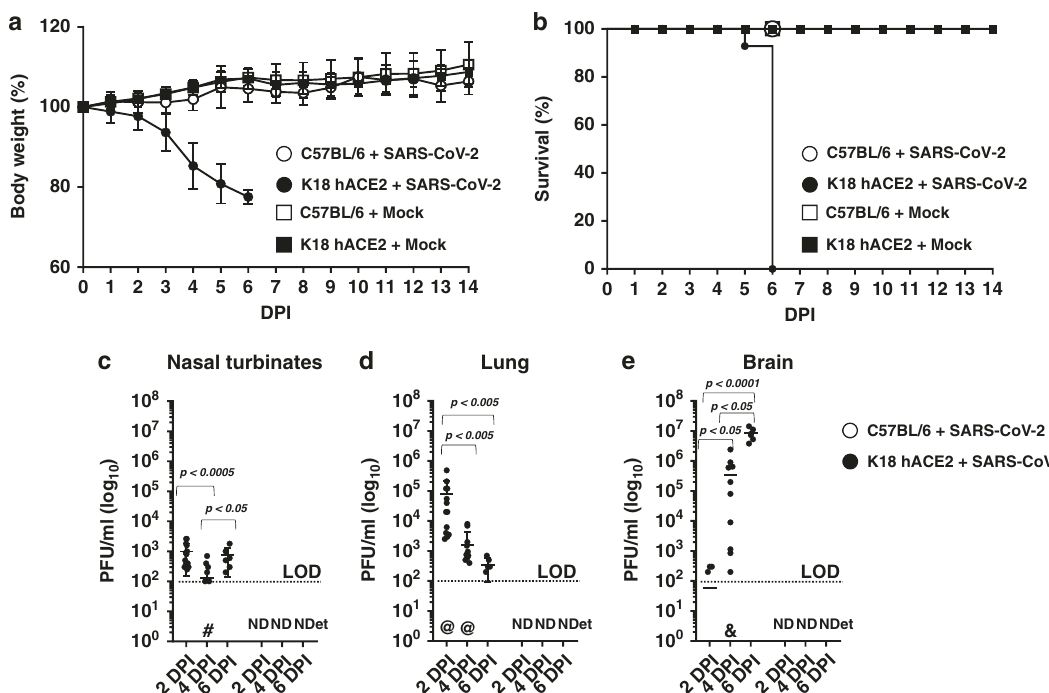
Fig. 1 Infection of K18 hACE2 transgenic and WT C57BL/6 mice with SARS-CoV-2. K18 hACE2 transgenic and WT C57BL/6 female and male mice were mock-infected or infected i.n. with 1 × 10 5 PFU of SARS-CoV-2. Body weight ( a , n = 14 and n = 6 for K18 hACE2 transgenic mice infected and mock-infected respectively; n = 8 for WT infected and n = 6 for WT mock infected) and survival ( b , n values equal as in a ) were evaluated at the indicated DPI. Mice that loss >25% of their initial body weight were humanely euthanized. Error bars represent standard deviations (SD) of the mean for each group of mice. c – e K18 transgenic hACE2 ( n = 34 mice distributed as n = 14 for 2 DPI, n = 14 for 4 DPI and n = 6 for 6 DPI, 50:50 male:female) and WT C57BL/6 ( n = 16 mice distributed as n = 8 for 2 DPI and n = 8 for 4 DPI) mice were similarly infected and killed at 2 and 4 DPI and viral titers in different organs (nasal turbinate, trachea, lung, brain, heart, kidney, liver, spleen, small intestine, and large intestine) were determined by plaque assay (PFU/ml). Data from virus -containing organs and/or tissue samples are shown: nasal turbinates c , lungs d , and brain e . Symbols represent data from individual mouse, and bars represent the geometric means of viral titers, p < 0.05; p < 0.005; p < 0.0005; p < 0.0001. @ virus not detected in one mouse, & virus not detected in four mice, # virus not detected in six mice, ND not detected, NDet non-determined. Dotted lines indicate the limit of detection, LOD (10 2 PFU/ml). DPI days post infection. Data are combined from two independent experiments. Source data are provided as a Source Data fi